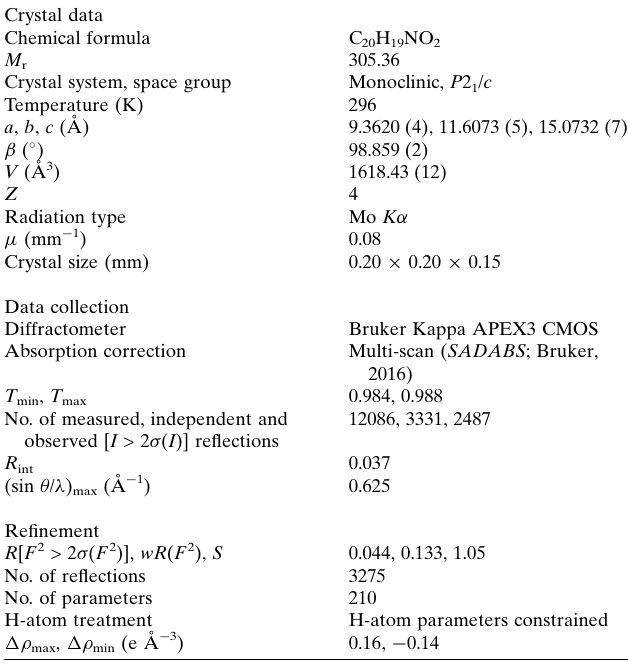
Crystal data Chemical formula